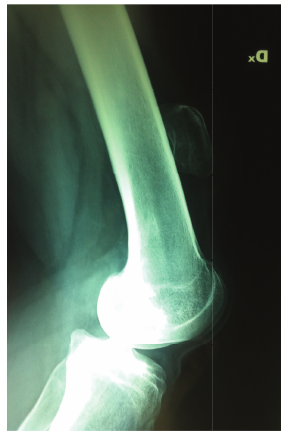
Figure 3: The LL X-ray of the knee showed no fractures, but an evidentproximaldislocationofthepatellaandsomecalcificdeposits on its inferior pole.